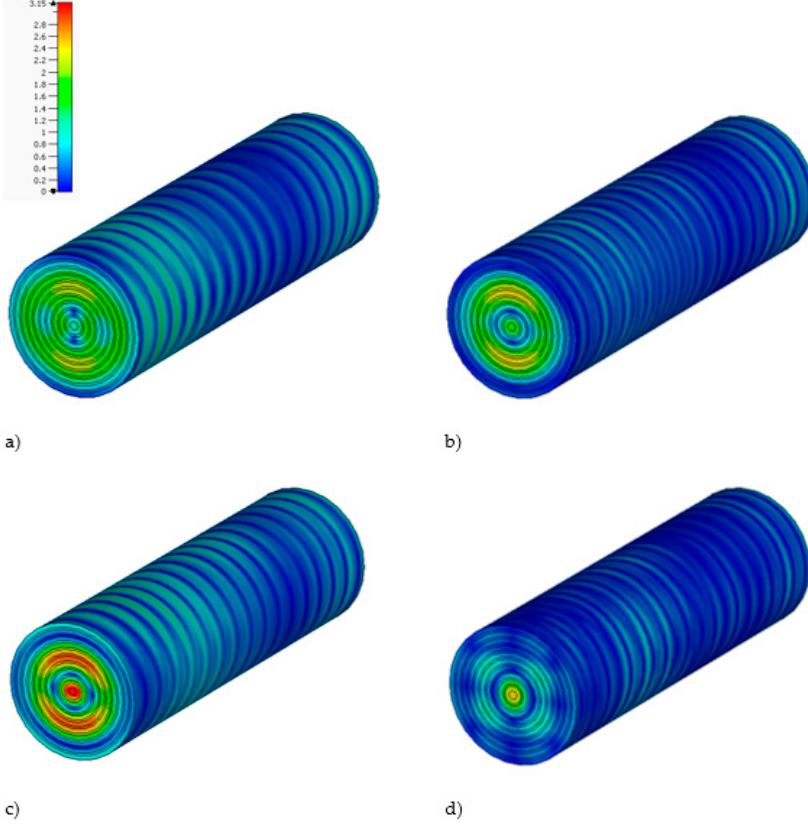
Figure 3. Electric field distribution inside wet poplar. ( a ) f = 2.45 GHz 50% permittivity variation; ( b ) f = 3 GHz 50% permittivity variation; ( c ) f = 2.45 GHz 100% permittivity variation; and ( d ) f = 3 GHz 100% permittivity variation.